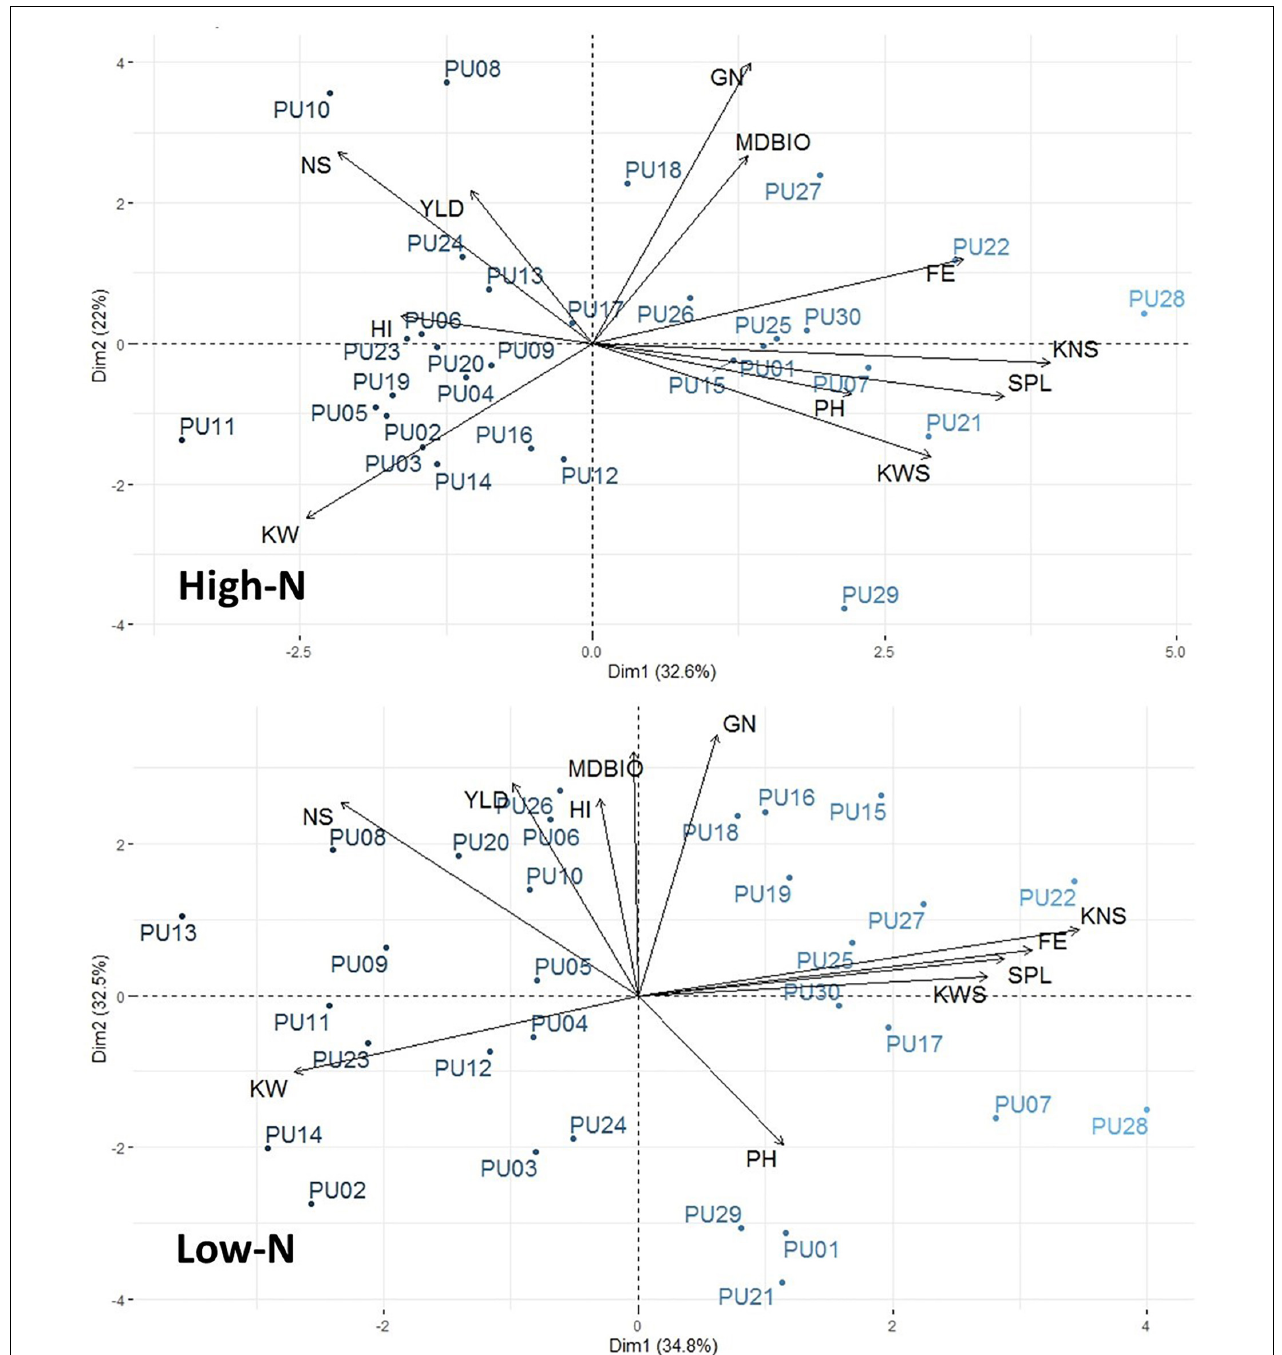
FIGURE 2 | Principal component analysis (PCA)-biplot analysis among 12 agronomic traits and 30 genotypes. PCA-biplots were performed in both high-N and low-N environments.